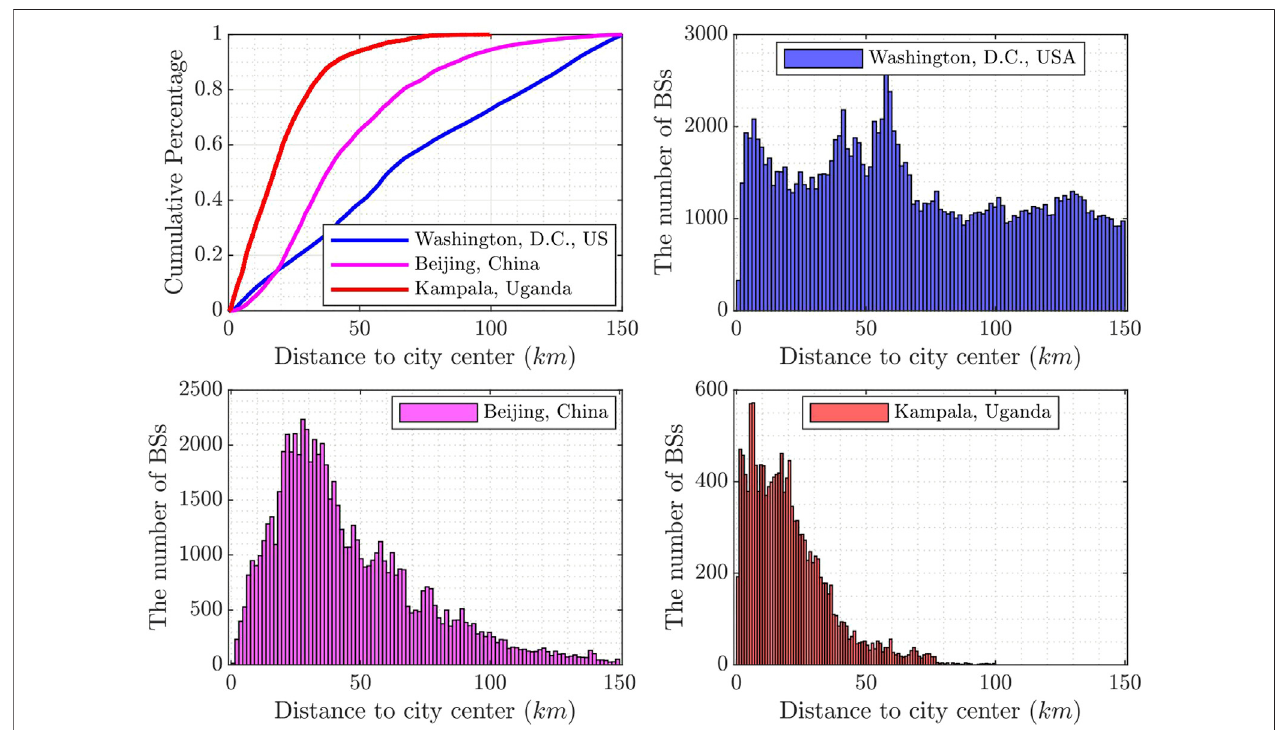
FIGURE 2 | Distribution of distances from each BS to the city center: Three case studies for representative cities.